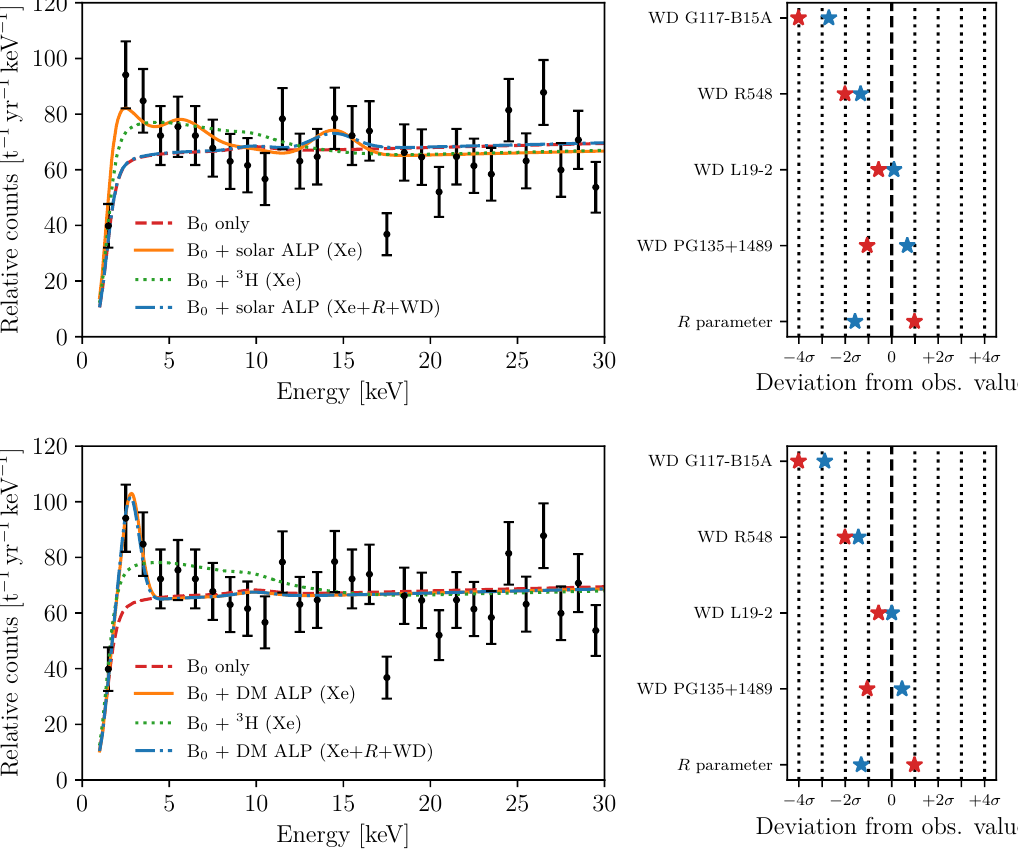
Figure 2. The best-fitting solar (top) and DM (bottom) ALP models. Left: we show the observed Xe data (black points and error bars) and the best-fit background (B 0 ; dashed red), B 0 + 3 H (dotted green), and B 0 + ALP models (solid orange). We also show the best-fit ALP + B 0 model for the XENON1T and astrophysical data (dashed-dotted blue). Right: a comparison of the best- fit predictions for the WD period decrease and R parameter for no ALP (red stars) and including ALPs (blue stars; with XENON1T and astrophysical